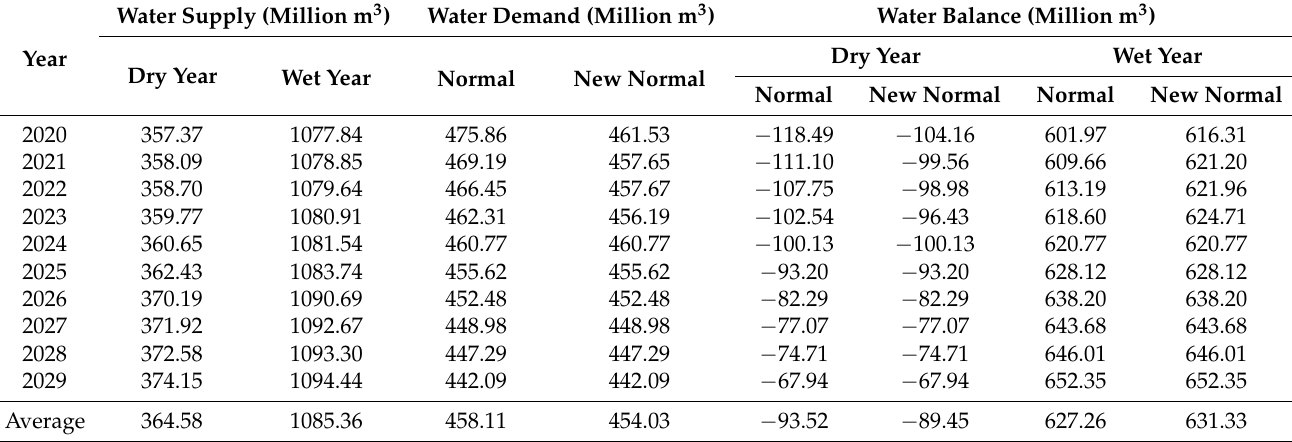
Table 26. The annual water supply and demand balance evaluation with the consideration of ecological water requirements between 2020 and